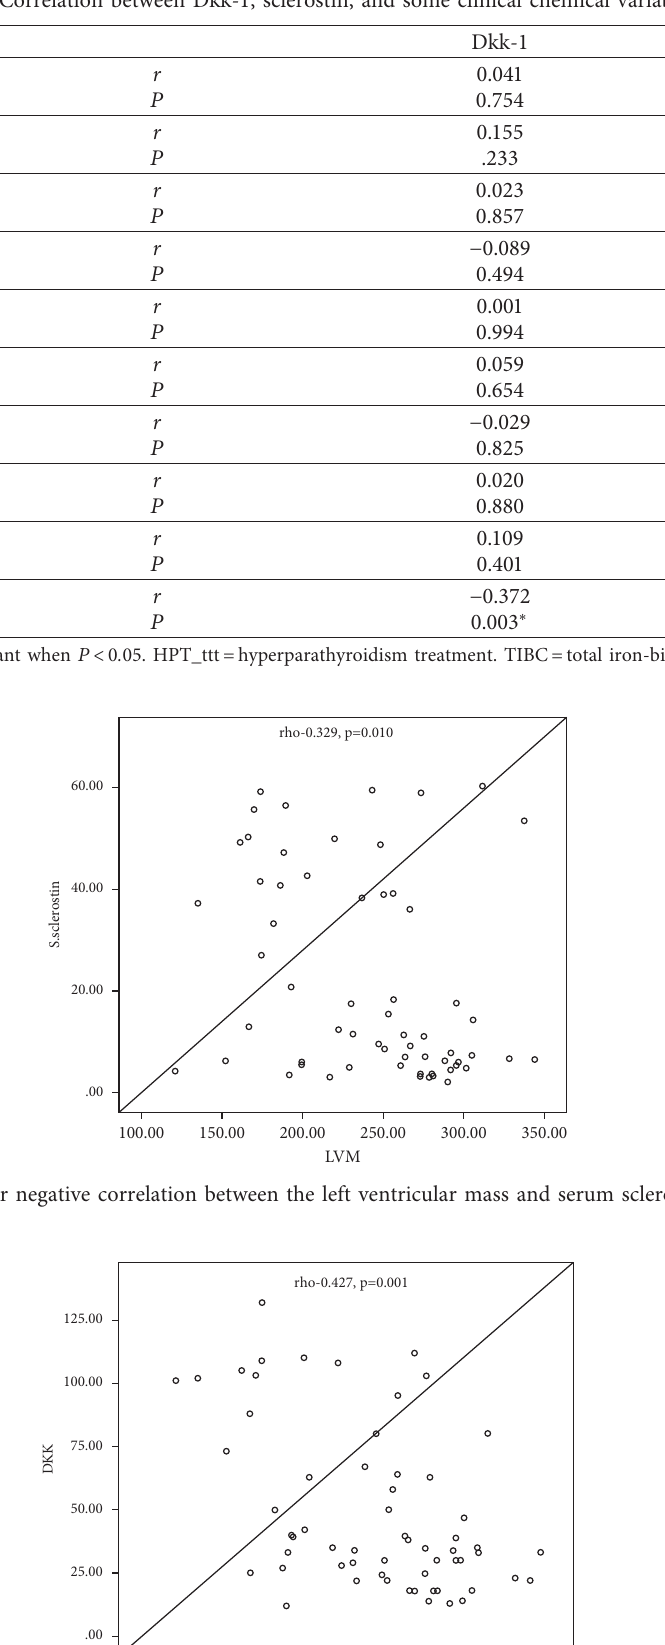
Table 8: Correlation between Dkk-1, sclerostin, and some clinical chemical variables.